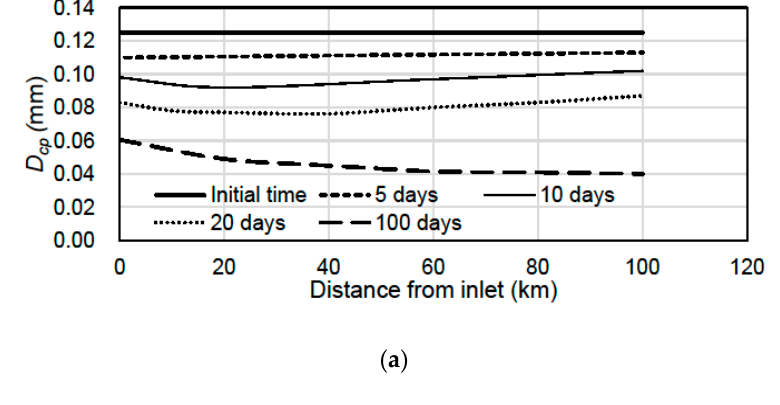
Figure 2. Temporal variation in the suspended-load under deposition conditions. ( a ) d cp ; ( b ) d 50 ; and ( c ) d 50 / d cp .